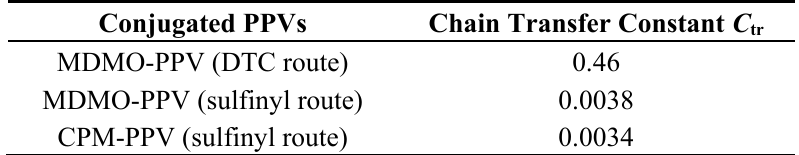
Table 2 . Chain transfer constant for conjugated PPVs synthesized via the sulfinyl ( T = 30 °C) and DTC ( T = 35 °C) precursor